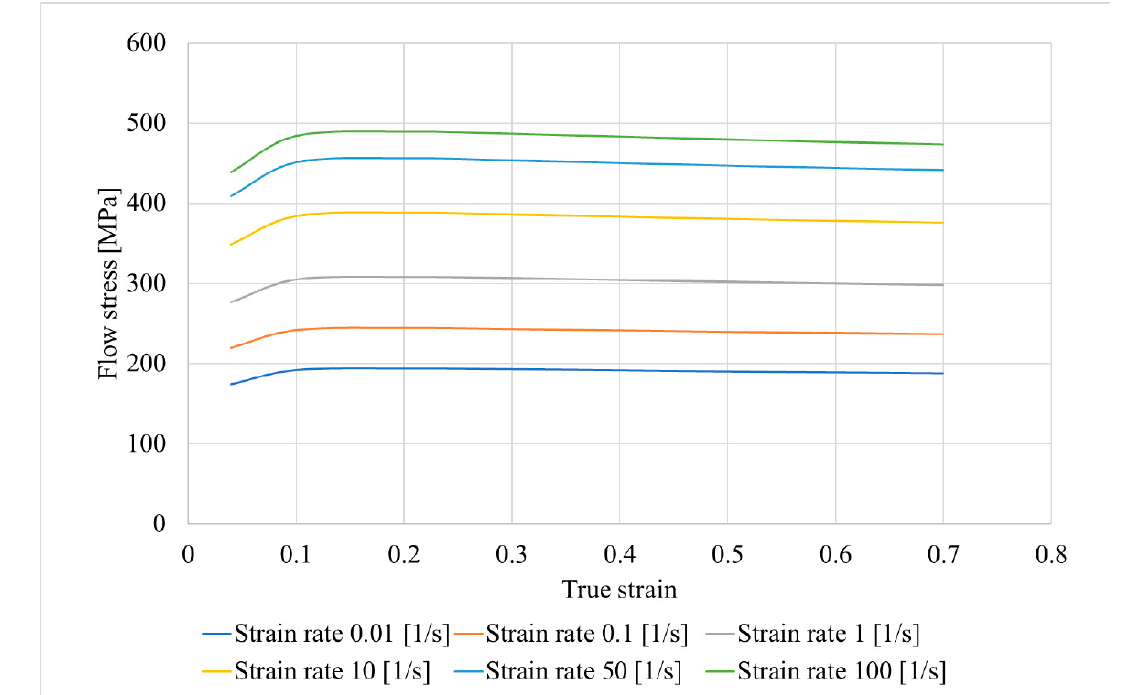
Figure 2. Flow stress of the Ti-6Al-4V alloy at 900 ° С for different strain rates. When the computer simulation was complete, 7 points with 4 mm equal distance between them were chosen in the cross section of the 48 mm diameter billet at the stationary stage. One of the points was in the center of the billet, and one was on the surface (Figure 3). The accumulated strain and the total velocity values were calculated for these points.